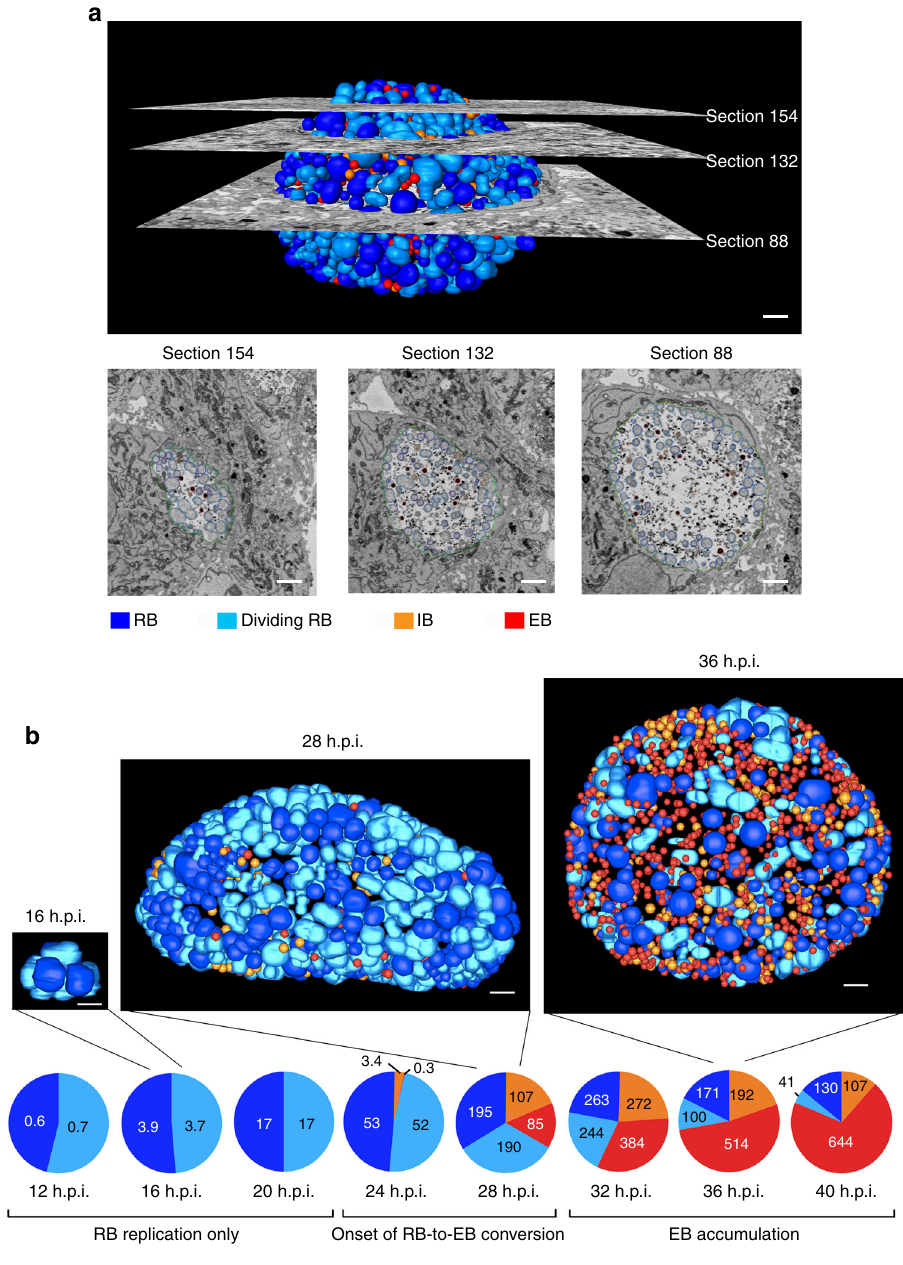
Fig. 1 Temporal analysis of chlamydial developmental forms using a three-dimensional electron microscopy approach. a Serial block-face scanning electron microscopy analysis (SBEM) was used to generate a three-dimensional computational reconstruction of the chlamydial inclusion in a C. trachomatis - infected HeLa cell at 28 h post infection (h.p.i.). Micrographs (middle) are shown for sections 154 and 132 (3/4 and halfway up from equator, respectively) and section 88 (equator), with segmentation markings for inclusion membrane (green), RBs (dark blue), dividing RBs (light blue), IBs (orange) and EBs (red). Scale bar: 1000 nm. b Entire chlamydial inclusions from representative infected cells at 16, 28, and 36 h.p.i. Scale bar: 1000 nm. Pie charts showing mean numbers of each chlamydial form per inclusion are grouped into three developmental phases: RB replication only (no IBs or EBs), onset of RB-to-EB conversion (IBs + EBs ≤ 50% of chlamydiae), and EB accumulation (IBs + EBs > 50% of chlamydiae). All four chlamydial forms inside each inclusion were identi fi ed and counted: 12 h.p.i. ( n = 50 inclusions), 16 h.p.i. ( n = 31), 20 h.p.i. ( n = 22), 24 h.p.i. ( n = 10), 28 h.p.i. ( n = 13), 32 h.p.i. ( n = 10), 36 h.p.i. ( n = 9), 40 h.p.i. ( n =